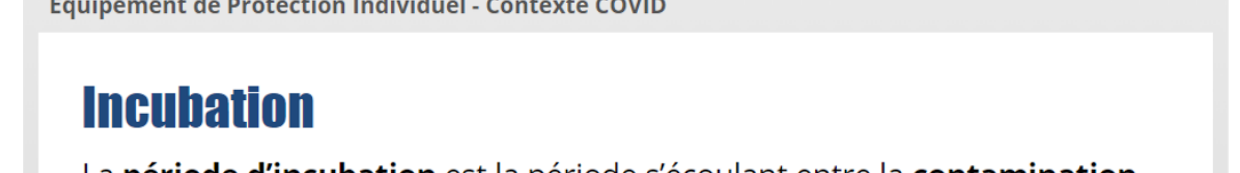
Figure 3. The learner has provided the wrong answer and is given the opportunity to retry. In this interaction, learners are allowed one more attempt if their first attempt